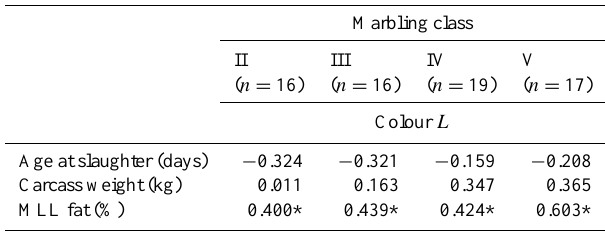
Table 4. Coefficients of Pearson’s correlation of colour L with slaughter and carcass